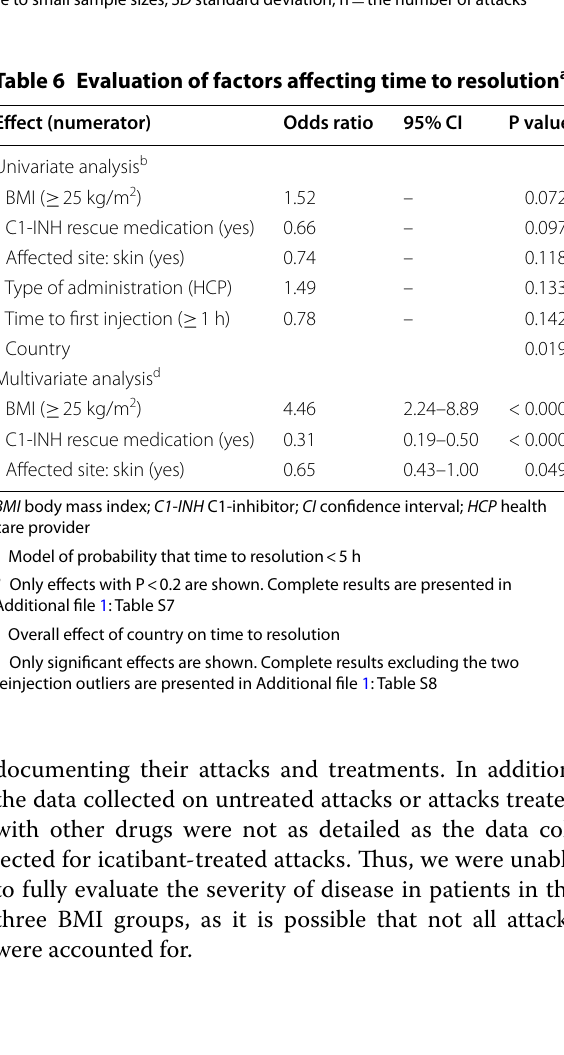
Results excluding the two outlier patients are presented in Additional file 1: Table S4 BMI body mass index; n.a. not applicable; statistical comparison was not conducted due to small sample sizes; SD standard deviation; n Table 5 Evaluation of factors affecting time to treatment a